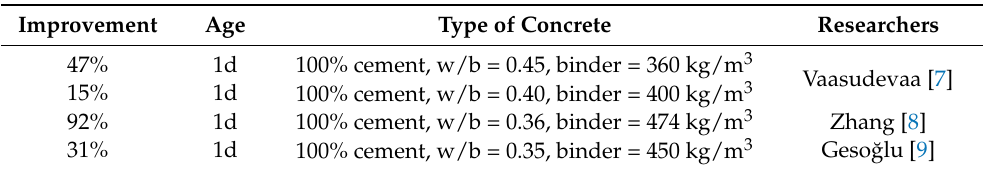
Table 1. Improvement in the early compressive strength of concrete with steam curing compared with standard curing.